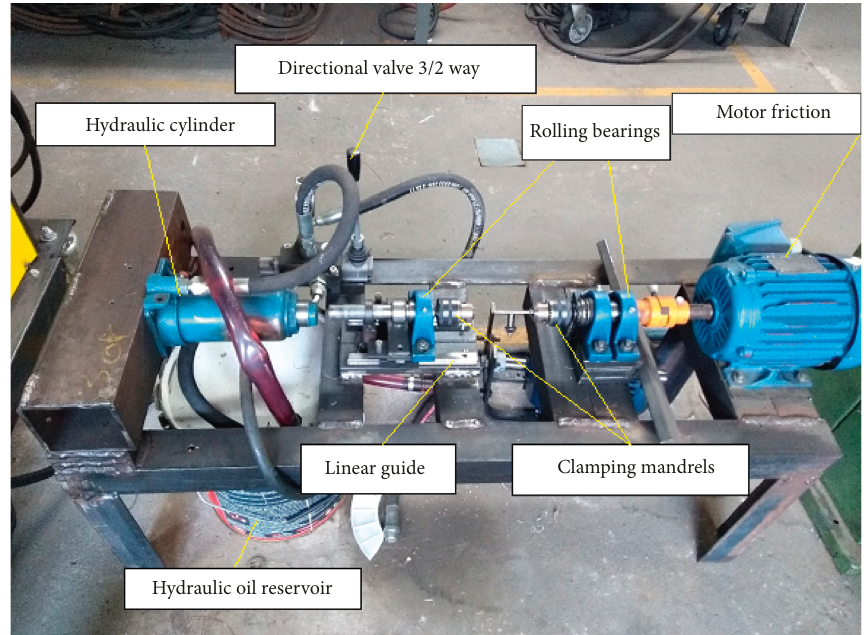
Figure 2: Friction welding machine.